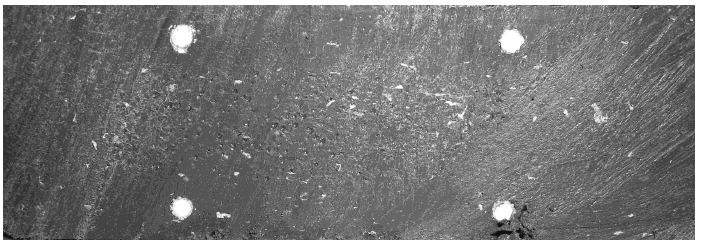
Figure 6. Picture of the cross section of the reinforced beam.